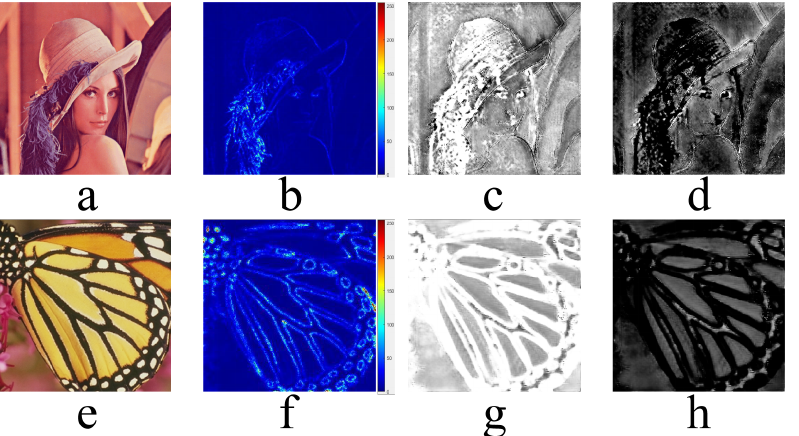
Figure 2. The EUM of the IG-DC. ( a , e ) “lenna” from Set14 and “butterfly” from Set5, ( b , f ) lenna’s EUM and butterfly’s EUM from the ID-DC, ( c , g ) lenna’s sEasy map and butterflt’s sEasy map from the EU-DC, ( d , h ) lenna’s sHard map and butterflt’s sHard map from the